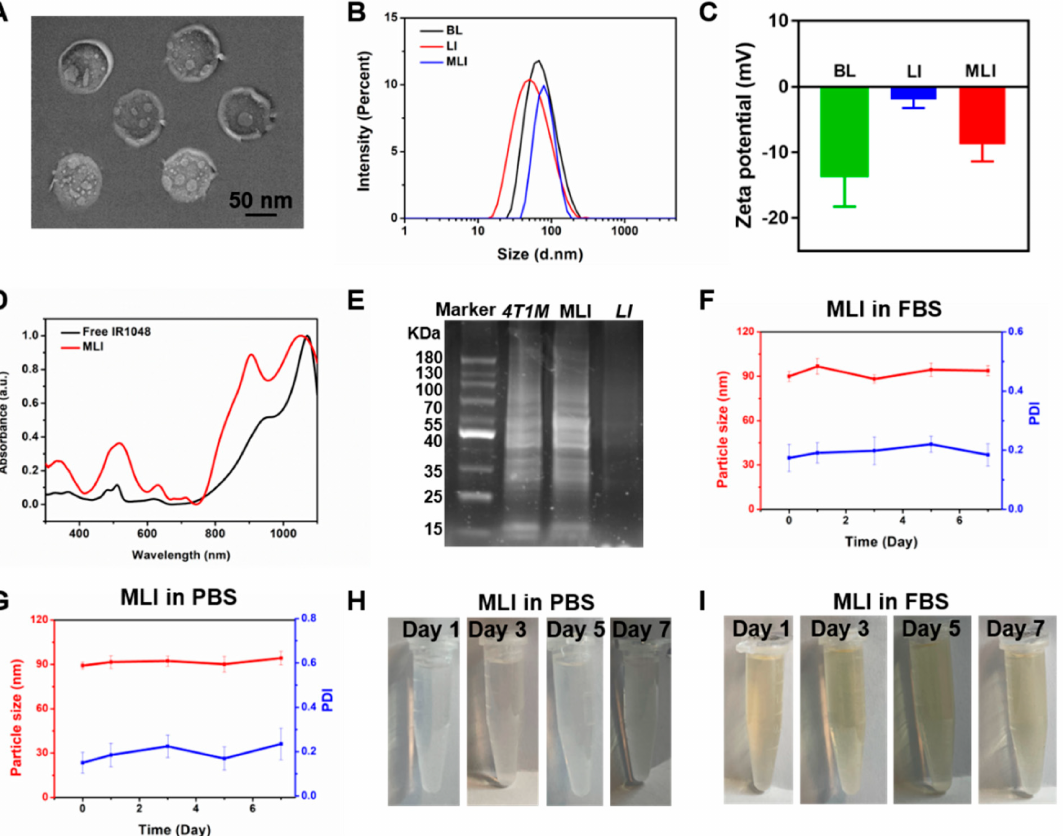
Figure 1. Characterization of MLI. ( A ) TEM image of 4T1 cell membrane-camouflaged